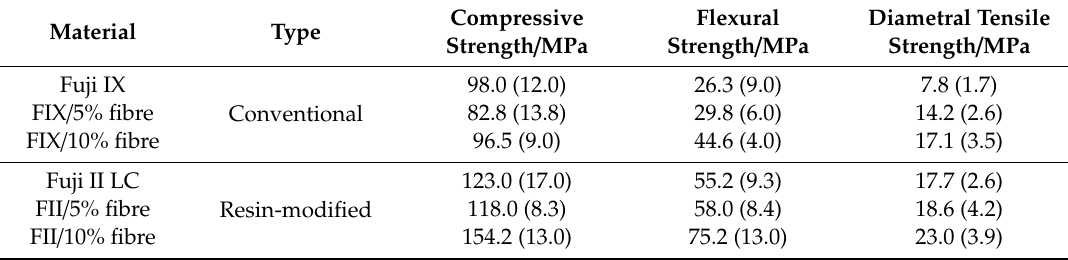
Table 4. Results of incorporating hollow glass fibres into glass-ionomer cements (standard deviations in